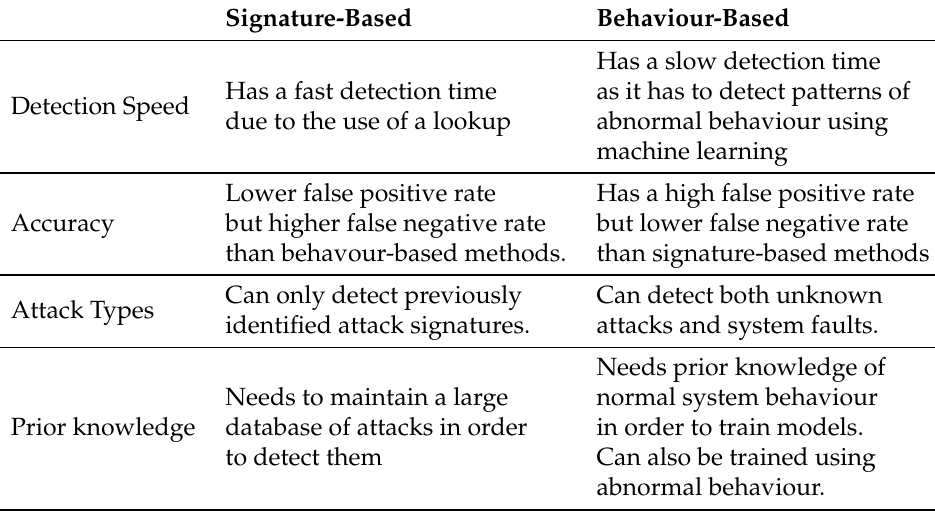
Table 1. Behaviour-based vs. Signature-based